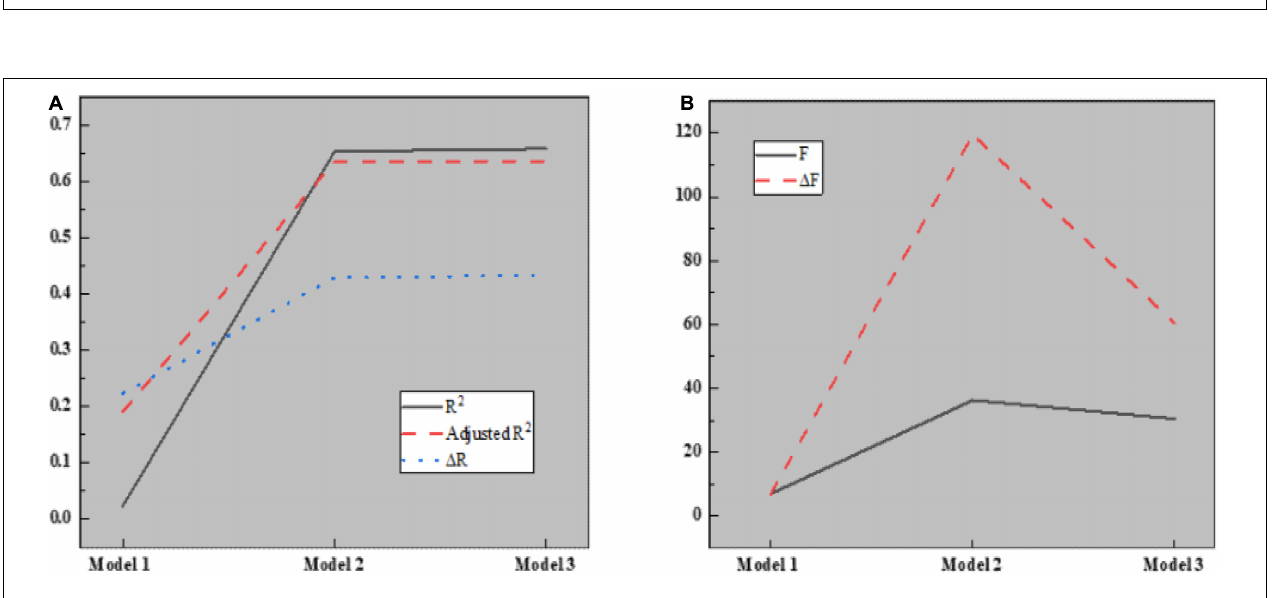
FIGURE 9 | Regression analysis results of knowledge hiding on temporary team performance in different models. (A) Regression model 1; (B) Regression model 2; (C) Regression model 3.